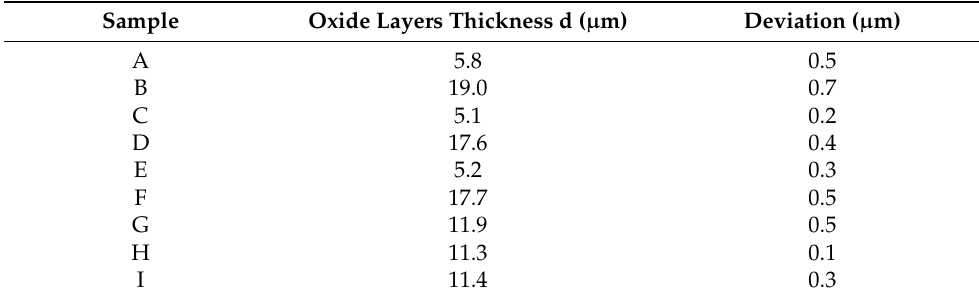
Table 2. List of Al 2 O 3 layers thicknesses produced in anodizing process.